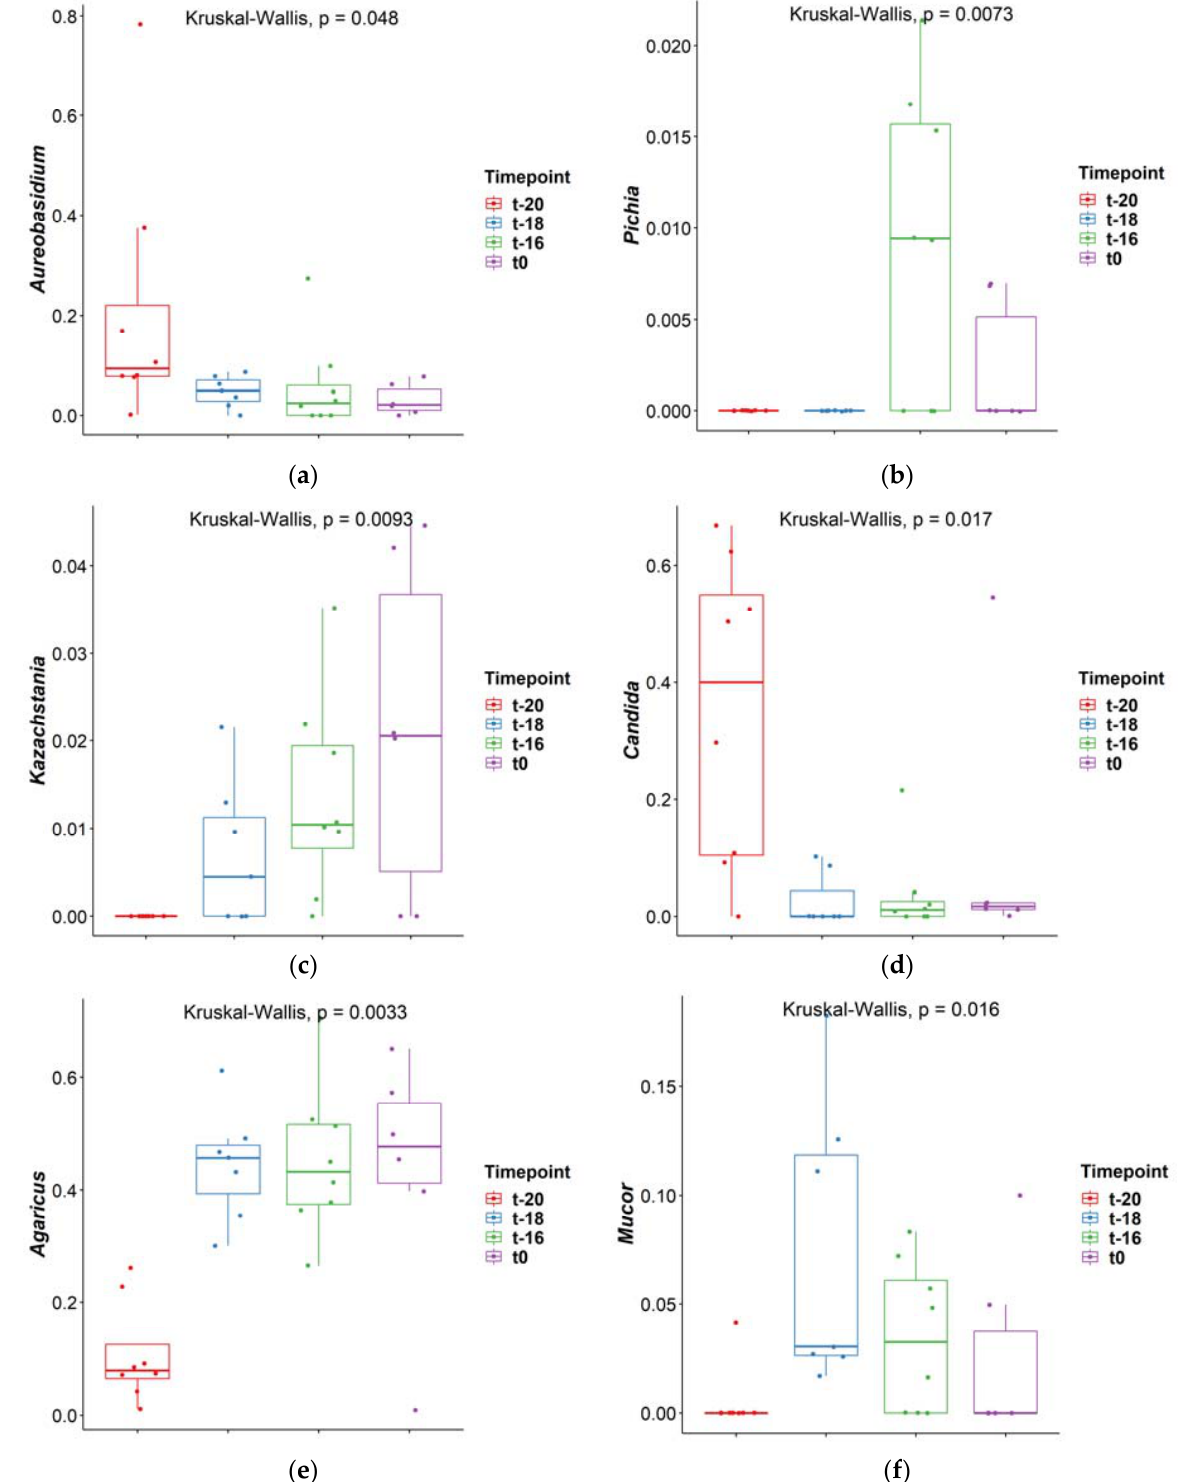
Figure 4. Box ‐ plot of genera: ( a ) Aureobasidium ; ( b ) Pichia ; ( c ) Kazachstania ; ( d ) Candida ; ( e ) Agaricus ; ( f ) Mucor that were significantly different (Kruskal–Wallis test) at different time points during the adaptation period ( p < 0.05). Dunn’s post hoc test was performed to indicate the groups that were significantly different.